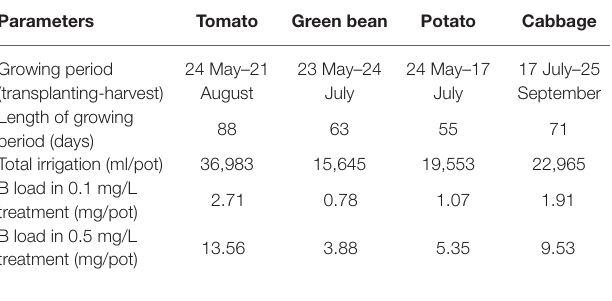
TABLE 2 | Irrigation parameters in the greenhouse.